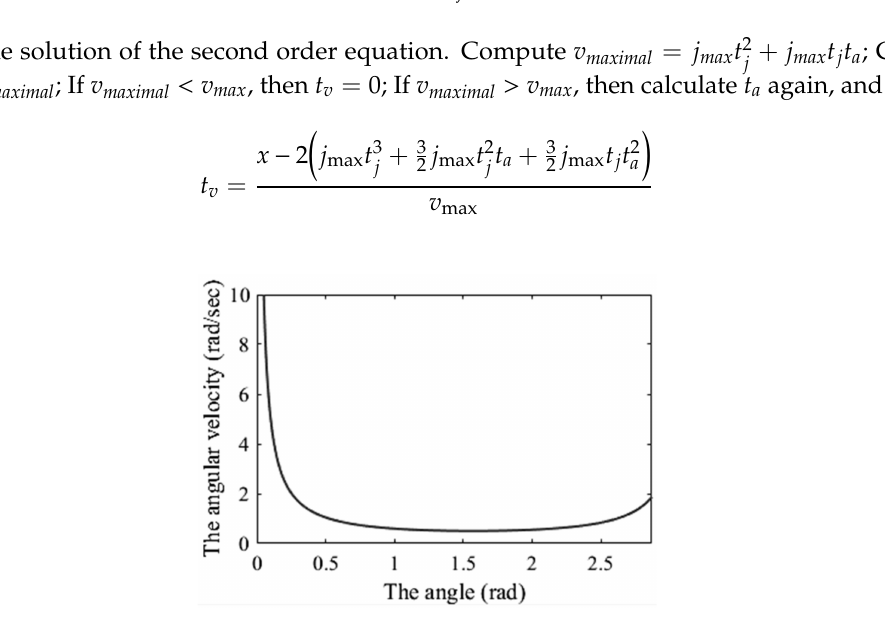
Figure 18. Description of the maximum angular velocity curve.